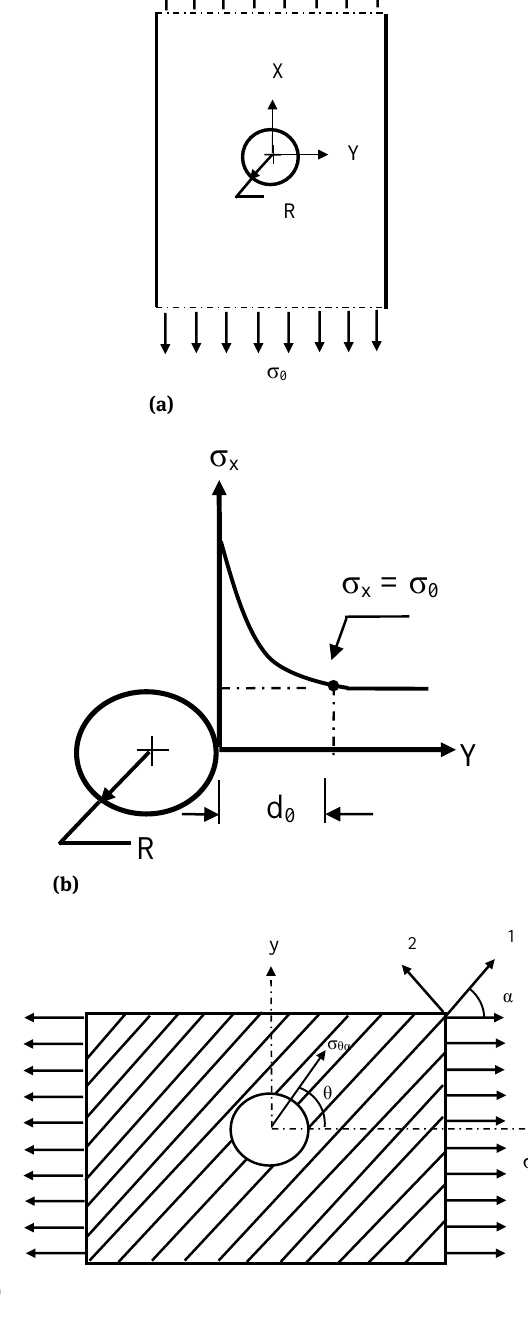
Figure 18: (a) An infinite plate with a circular hole subjected to uni- axial tension, (b) stress distribution around hole, (c) a composite plate with hole subjected to uniaxial tension at an angle of 𝛼 ∘ from fiber direction